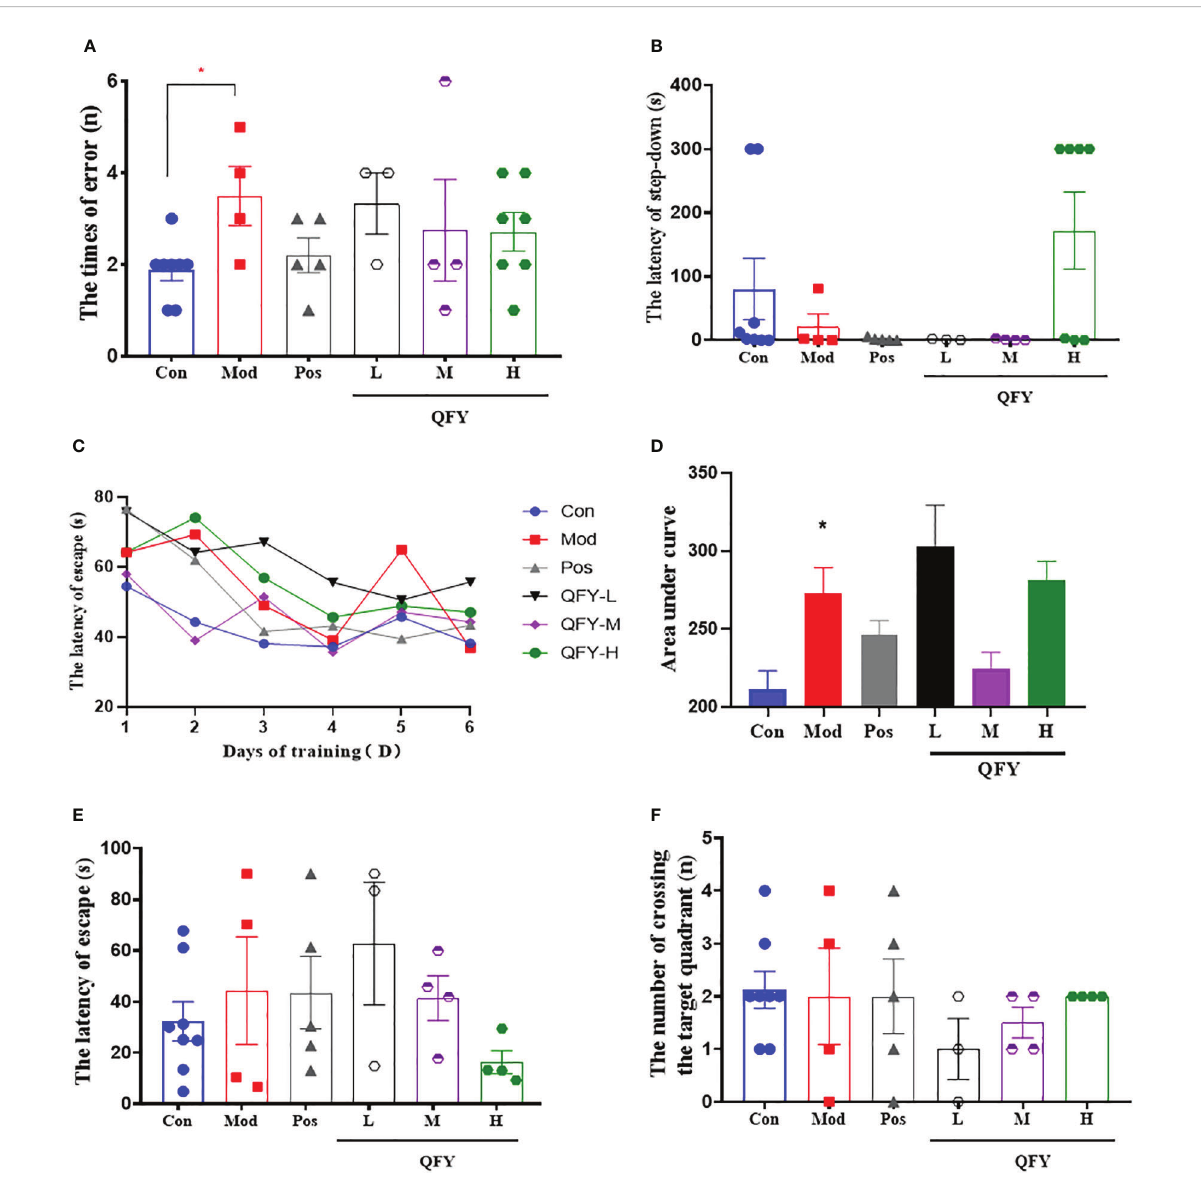
FIGURE 3 Effects of Qi-Fu-Yin on cognitive impairments in APP/PS1 transgenic mice. Step-down test (A, B) and Morris water Maze test (C – F) . (A) The times of errors during learning period, (B) The latency of step-down during test period, (C) The latency of escape in hidden-platform training session, (D) Area under curve (AUC) for the latency of escape in hidden-platform training session, (E) The latency of escape in probe trial session, (F) The number of crossing the target quadrant in probe trial session. Mean ± SEM, n=3~8, * P <0.05, vs control (Con) group, unpaired Student`s t -test; vs model (Mod) group, one-way ANOVA analysis followed by Dunnett ’ s multiple comparisons test, Graphpad Prism 8.0.1